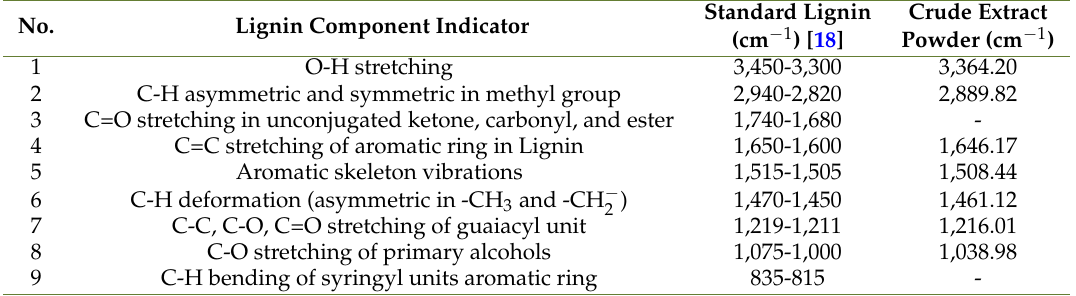
Table 1. Comparison of the Wavelength Spectrum of Solid Lignin with Standard Lignin